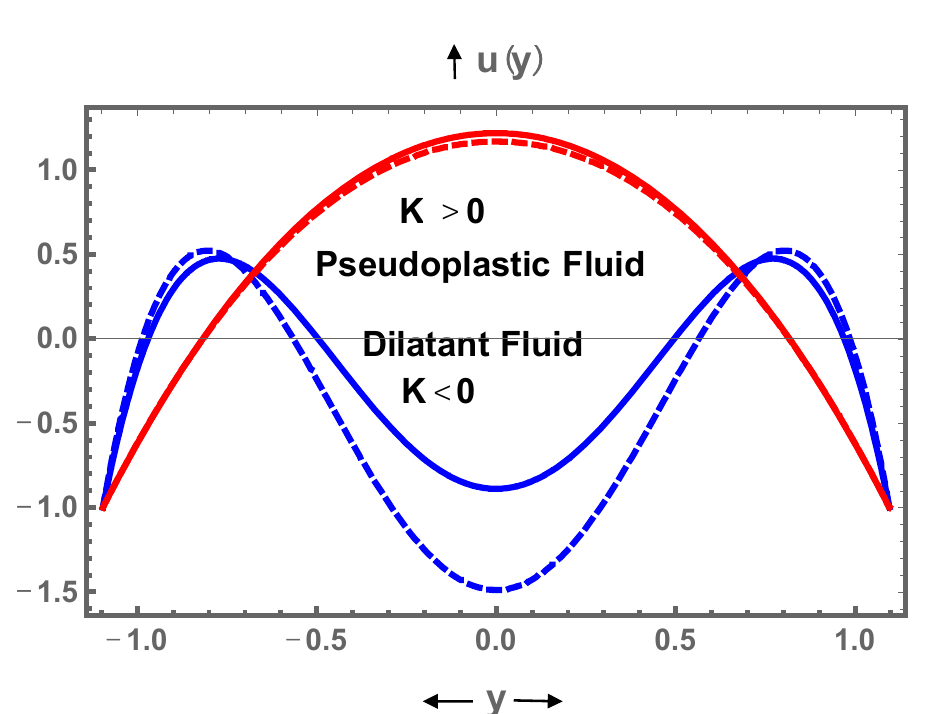
Figure 16. Display of axial velocity for pseudoplastic and dilatant fluids.